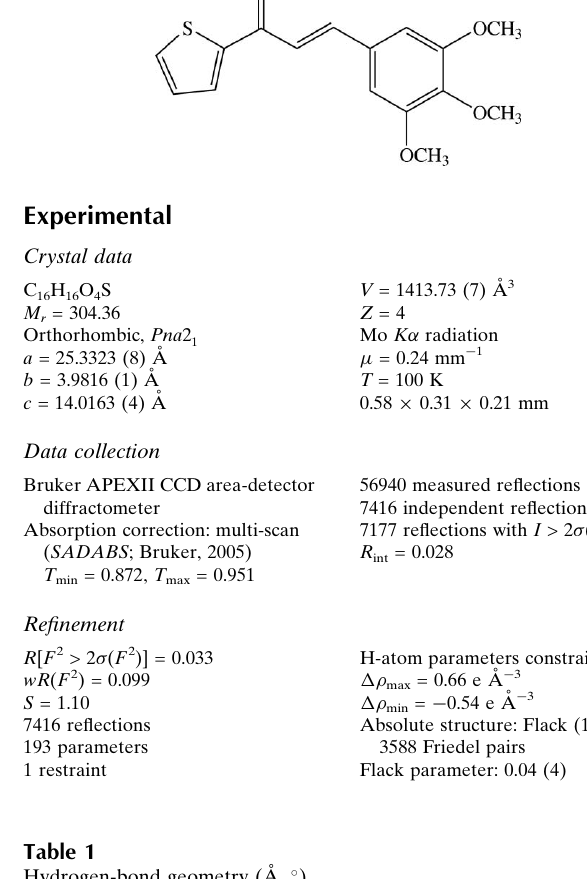
Hydrogen-bond geometry (A˚ , (cid:2)